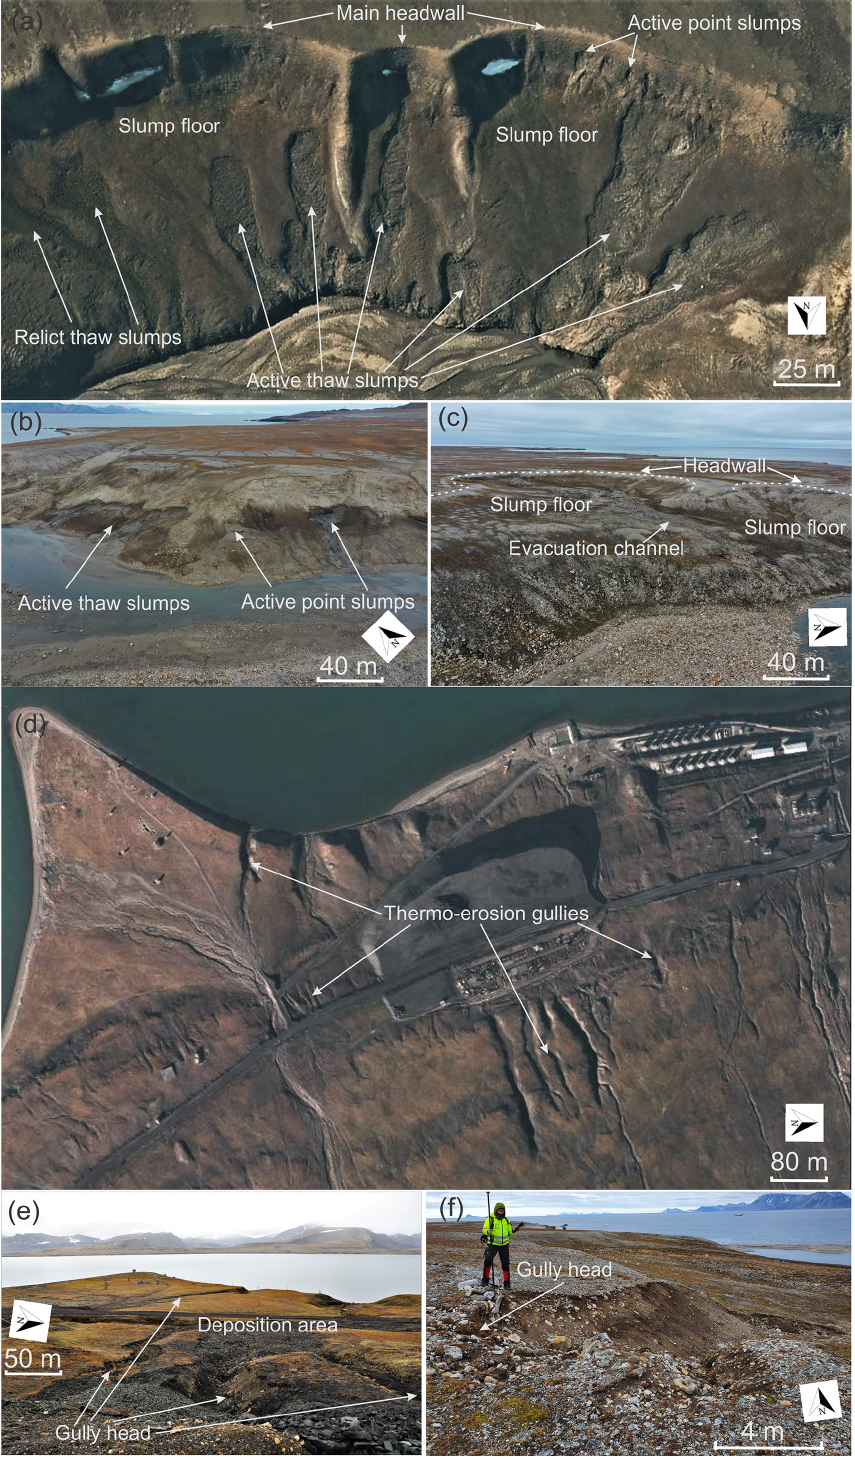
Figure 2. (a) TSs on a north-facing slope on the left side of the Hanaskogelva river in proximity to Advent City (orthophoto by © NPI, 2022a). (b) UAV photo of active TSs and active point slumps along the right side of Linnéelva river, close to Russekeila. (c) UAV photo of an inactive TS (left side) and an active TS (right side) along the left side of Linnéelva river, close to Russekeila. (d) Thermo-erosion gullies on a western-facing slope in Finneset, south of Barentsburg (orthophoto by © NPI, 2022a). (e) Photo of gully heads and their deposition areas south of Barentsburg. (f) Gully head cut into uplifted beach and marine deposits on the left side of Linnéelva river, close to Russekeila.